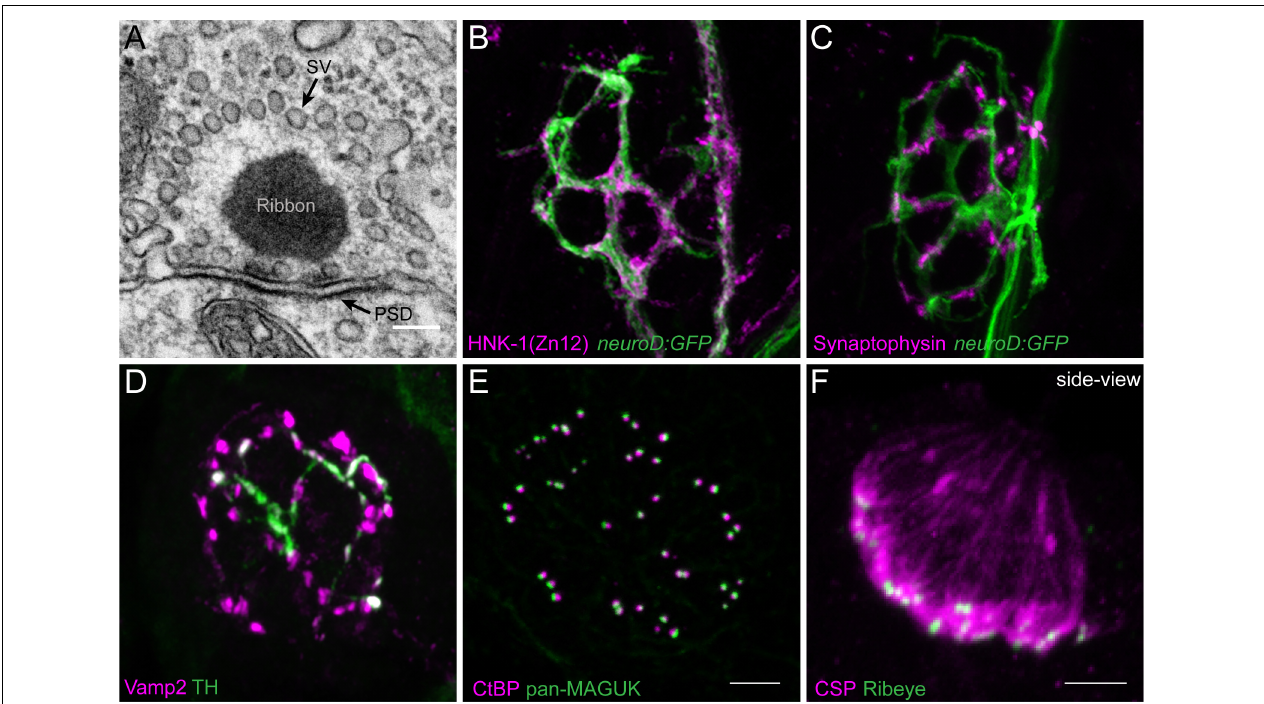
FIGURE 2 | Morphological examination of hair-cell synapses in zebrafish. (A) Classically, transmission electron microscopy (TEM) has been used to visualize hair-cell synapses. Shown is a micrograph of a hair-cell synapse from a zebrafish lateral-line hair cell. In this micrograph, the presynaptic ribbon is a dark spherical density. Surrounding the presynaptic ribbon are synaptic vesicles (SV). Beneath the presynaptic ribbon along the plasma membrane is the postsynaptic density (PSD). (B) The neurod:GFP transgene (green) can be used to label the afferent neurons innervating lateral line (shown in A,B ), as well as afferents that innervate inner-ear hair cells. Afferent fibers can be labeled with the commercial antibody HNK-1/Zn12 (pink). (C) Neurod:GFP (green) can be co-labeled with a Synaptophysin antibody (pink) to label both afferent fibers and all efferent synapses respectively. (D) Efferent synapses, which can also be labeled with a Vamp2 antibody (pink), can be further sub-classified by a co-label such a tyrosine hydroxylase (TH, green; white overlap indicates dopaminergic synapses). (E) Pre- and post-synaptic densities can be labeled with CtBP (pink) and pan-MAGUK (green) antibodies respectively. (F) Synaptic vesicles, labeled with cysteine string protein (CSP, pink) are enriched at the basolateral membrane of hair cells near synaptic ribbons labeled with Ribeye antibody (green). Scale bar = 100 nm in (A) and 5 µ m in (E) (for B–E ) and (F)